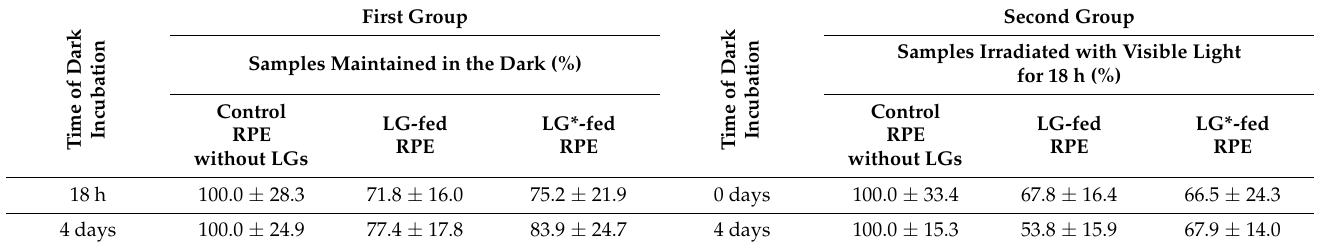
Table 2. MTT cell viability assay when RPE samples were maintained in the dark or after irradiation of RPE samples with visible